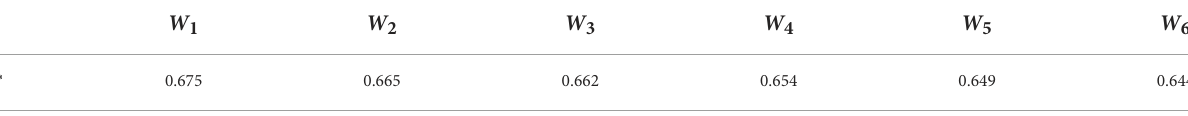
TABLE 14 The PDA